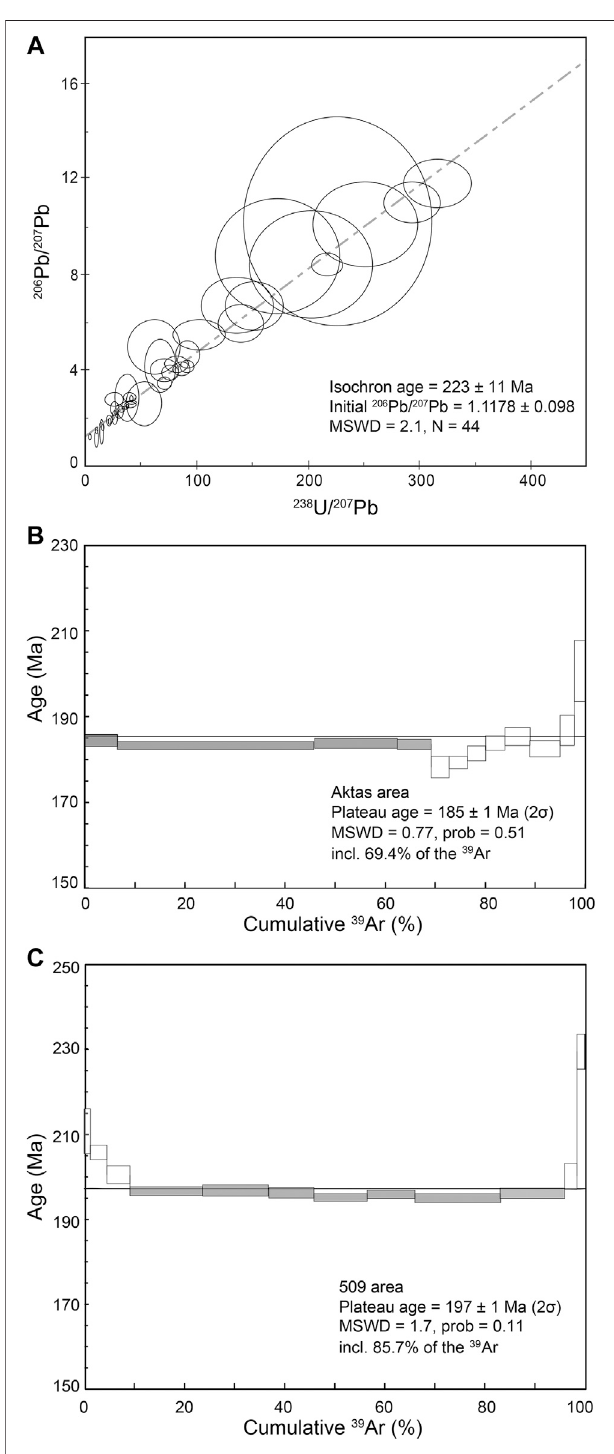
FIGURE 12 | Geochronology of cassiterite from spodumene-bearing pegmatite from the 505 Li deposit: (A) U-Pb isochron diagram for cassiterite; (B) 40 Ar- 39 Ar spectra age for muscovite from the Aktas Li-deposit; and (C) 40 Ar- 39 Ar spectra age for muscovite from the 509 Li deposit.